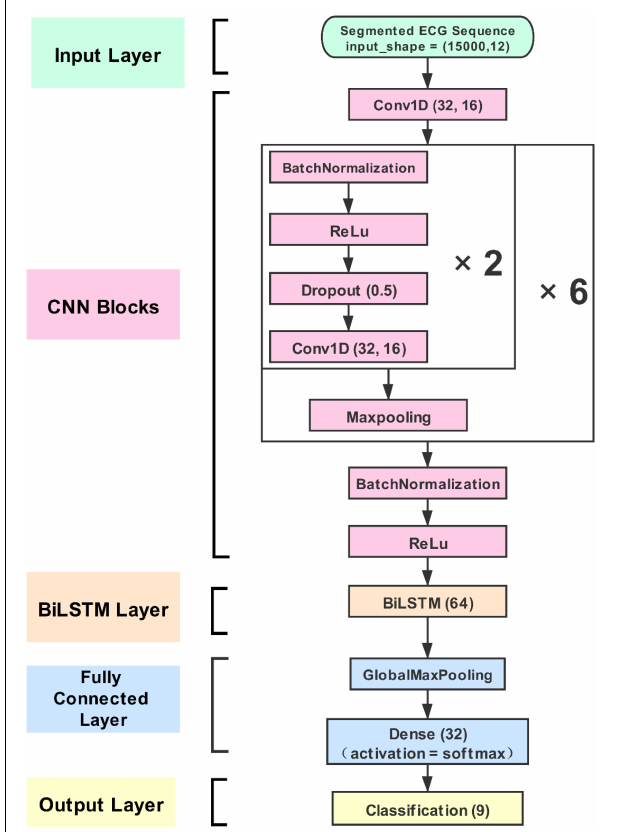
FIGURE 2 | The proposed convolution neural network (CNN)-bidirectional long short-term memory (BiLSTM) structure. The CNN strategy can extract more convolution features from electrocardiogram (ECG) signal, and the BiLSTM strategy can learn effectively by selecting from the optimal features extracted to improve classification accuracy. The proposed model is generic and can be easily used for other